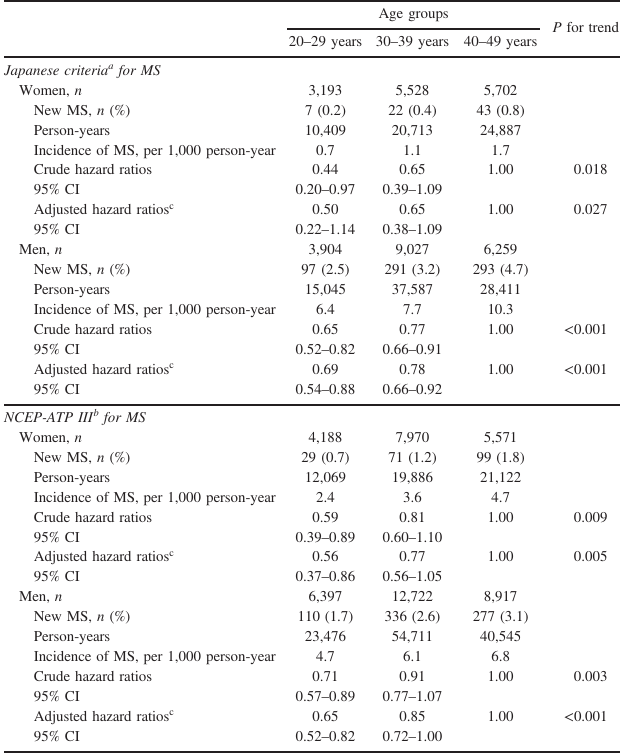
Table 3. Associations between age groups and new MS during 6-year follow-up Age groups Japanese criteria a for MS Women, n